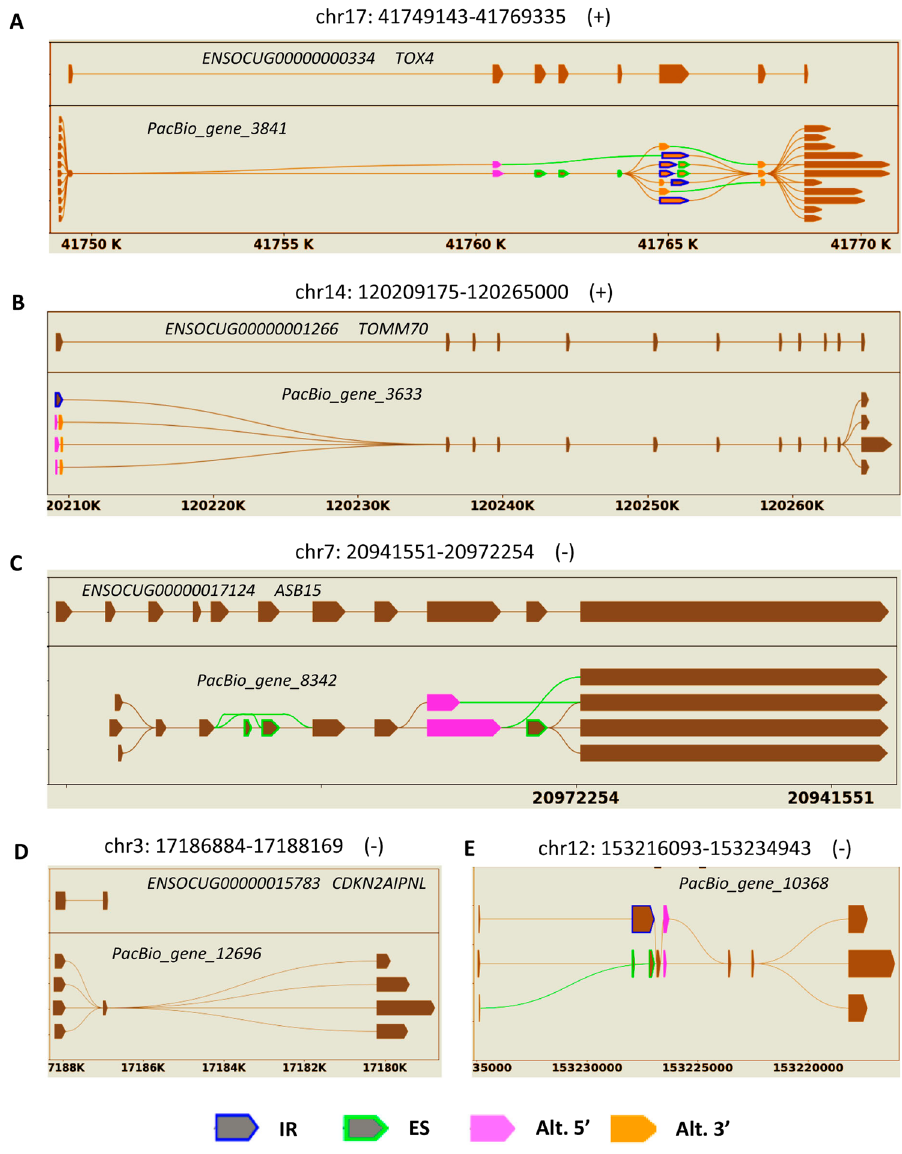
Figure 2. Schematic illustration of alternative isoforms within the PacBio transcriptome. The reference gene models in Ensembl are accordingly placed on upper side and labelled by chromosomal locations, gene ID and name. AS events could be found extensively ( A ) or exclusively detected within terminal exons ( B ). The events of ES and Alt. 5 ′ are specially shown with the shrunk length of introns ( C ). The newly revealed exon ( D ) and gene ( E ) in reference to Ensembl gene models are also